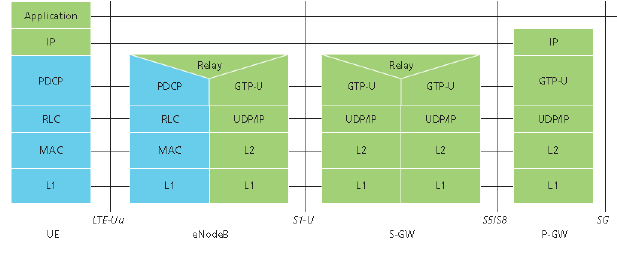
Fig. 2. 4G User plane architecture [5]